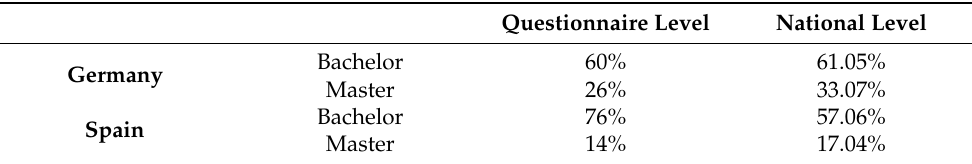
Table 38. Ratio of students in Bachelor’s and Master’s courses in the questionnaire and on national